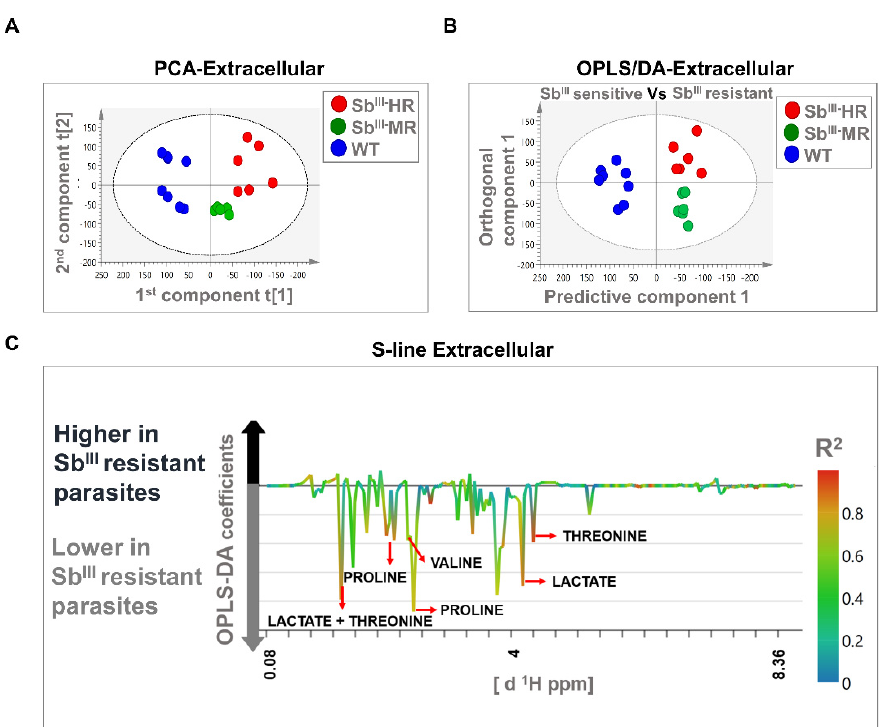
Figure 5. Multivariate analysis showing significant differences in metabolomic profiles of sensitive and resistant Leishmania parasites at the extracellular level by 1 H-NMR. ( A ) Score plot of PCA. ( B ) OPLS-DA score plot comparing antimony-resistant vs. antimony-sensitive parasites. ( C ) S-line plot highlighting the metabolites with major contributions to group separation. Each individual dot in panel ( A ) or ( B ) represents an observation or sample. Some dots can be overlapped. Blue dots: WT strain; green dots: MR strain; red dots: HR strain. The dotted ellipse of score plots describe the 95% confidence interval of the Hotelling’s T-squared distribution. The color bar in the S-line plot corresponds to the absolute value of the correlation loading in the discrimination model. A total of 20 observations or independent biological replicates are shown, 8 of them correspond to WT, 6 to MR, and 6 to HR group.